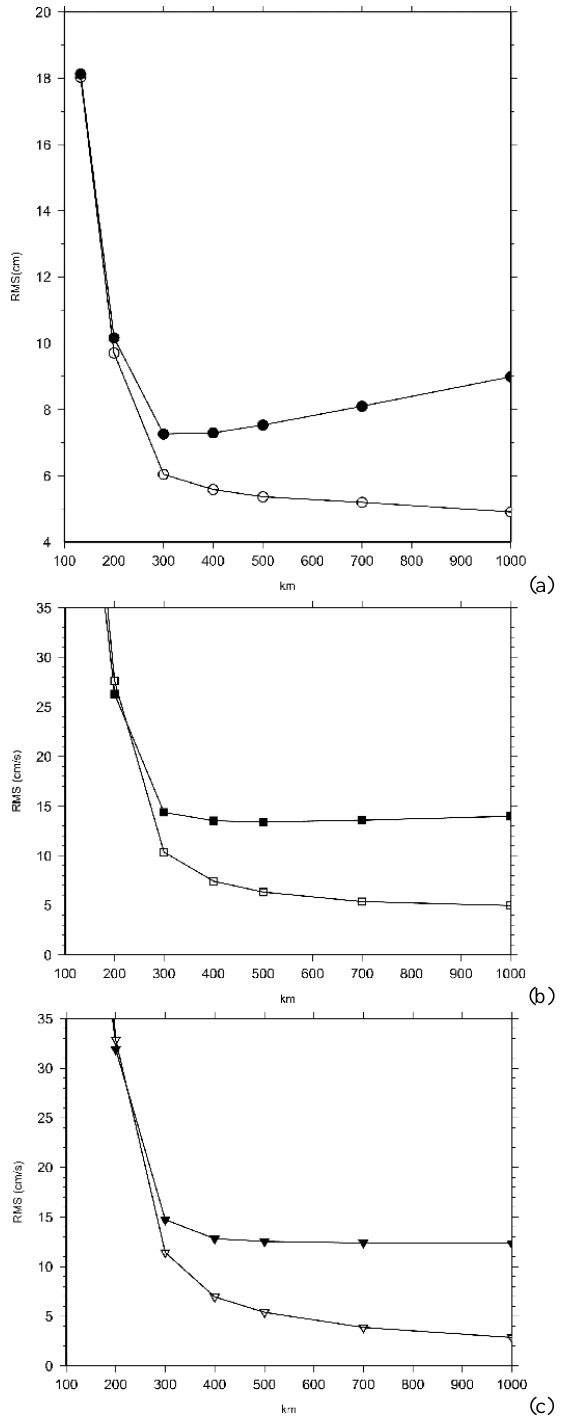
Fig. 3. RMS differences between synthetic and direct MDT esti- mates as a function of filtering length. Black symbols: only the di- rect MDT quantities are filtered (RMS 1 ). White symbols: both the direct and the synthetic estimates are filtered at the same resolution (RMS 2 ). (a) Height RMS differences. (b) Zonal Geostrophic ve- locity RMS differences. (c) Meridional Geostrophic velocity RMS